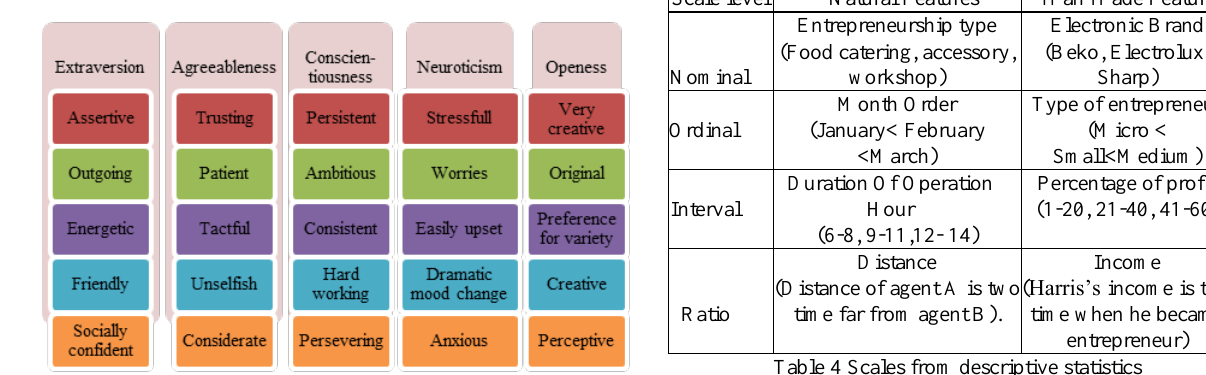
Figure 2 Personality traits in Big Five